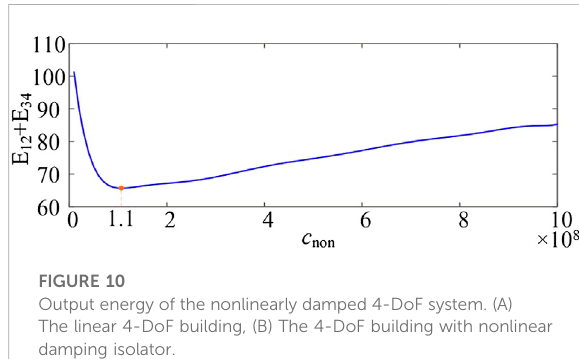
FIGURE 10 Output energy of the nonlinearly damped 4-DoF system. (A) The linear 4-DoF building, (B) The 4-DoF building with nonlinear damping